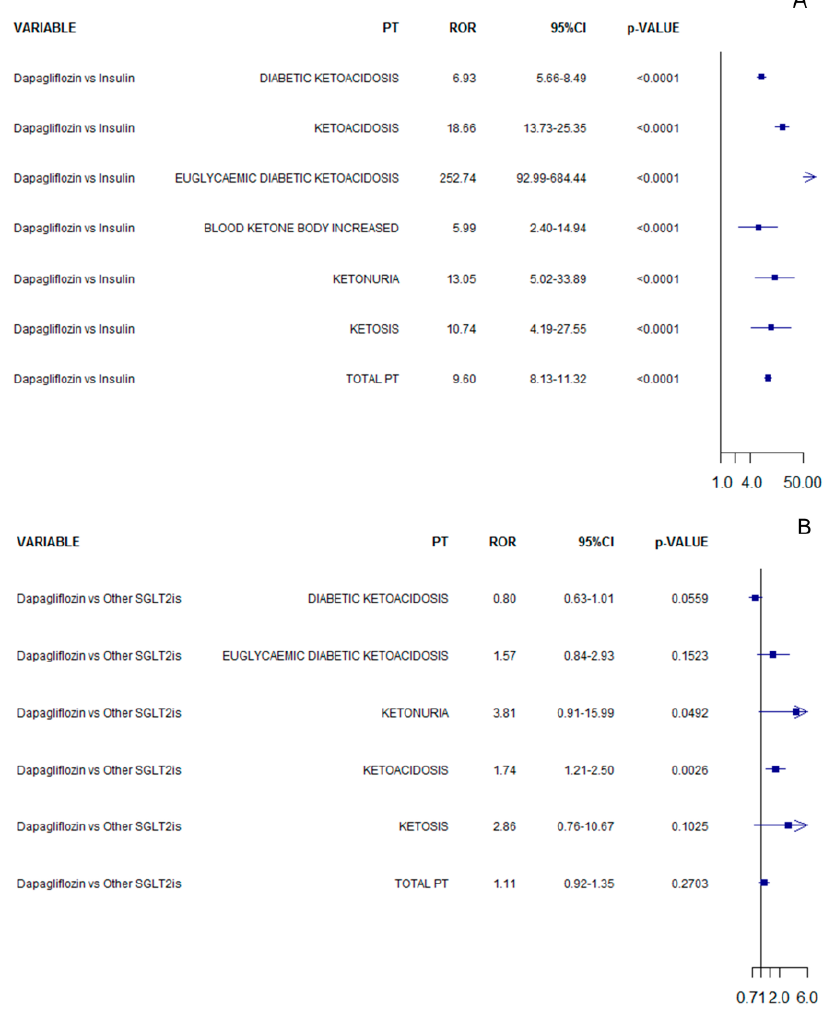
Figure 2. ROR of ketoacidosis adverse events for dapagliflozin compared to insulin ( A ) or other SGLT2 inhibitors ( B ) in T1DM.